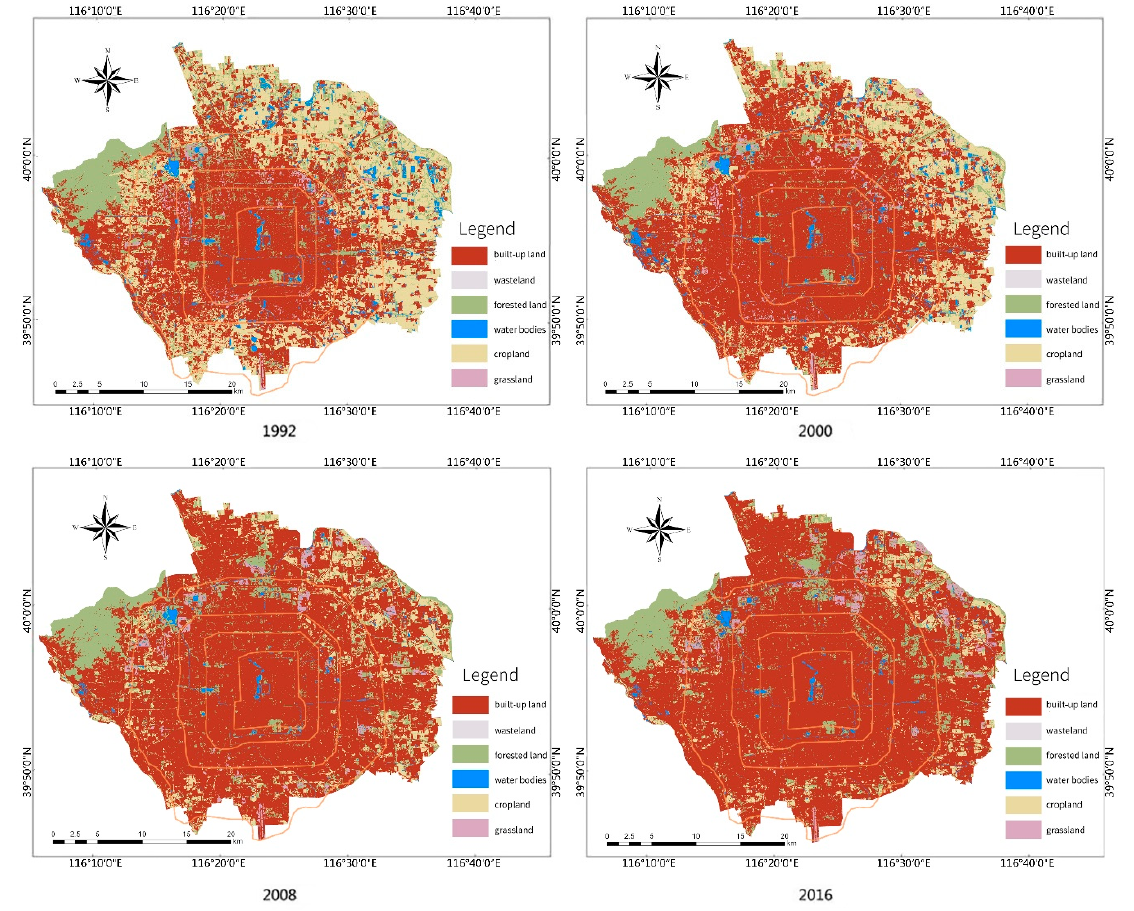
Figure 3. Interpretive maps depicting land use in central Beijing in 1992, 2000, 2008, and 2016.